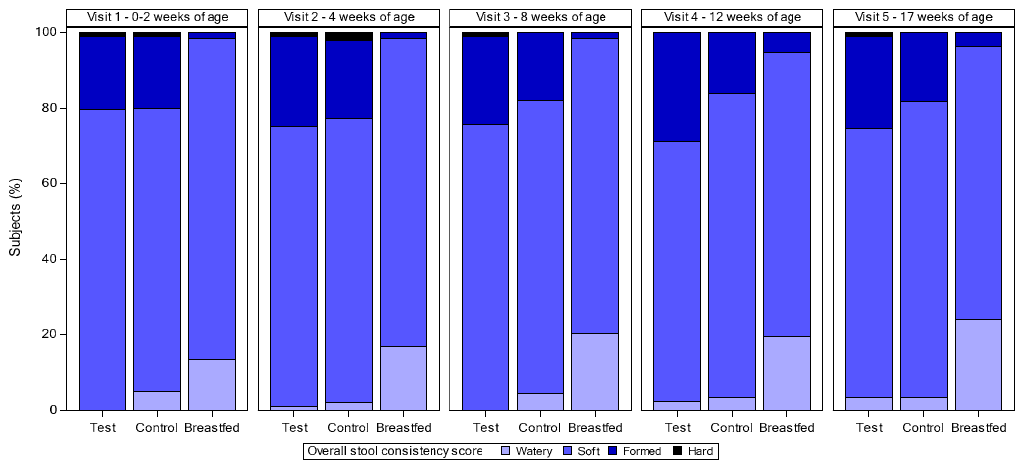
Figure 3. Percentage of infants per stool consistency category based on their mean stool consistency visit per visit. All subjects treated population and Breastfed Reference. Chi-square test was used for comparison between the Test and Control groups (V1: p = 0.147; V2: p = 0.803; V3: p = 0.119; V4: p = 0.120; V5: p = 0.569). Number of subjects per group for Test, Control, and Breastfed group, respectively—V1: n = 103 / 99 / 59; V2: n = 100 / 97 / 59; V3: n = 94 / 89 / 59; V4: n = 90 / 87 / 56; V5: n = 90 / 87 /